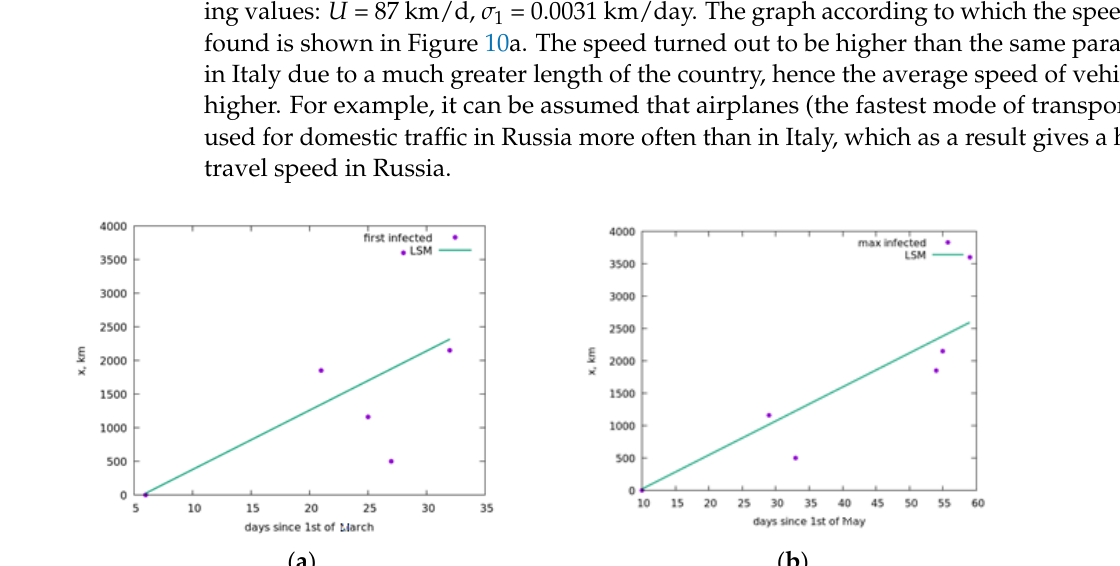
Figure 10. Graphs for determining ( a ) speed of spread of the epidemic and ( b ) speed of recovery in Russia.